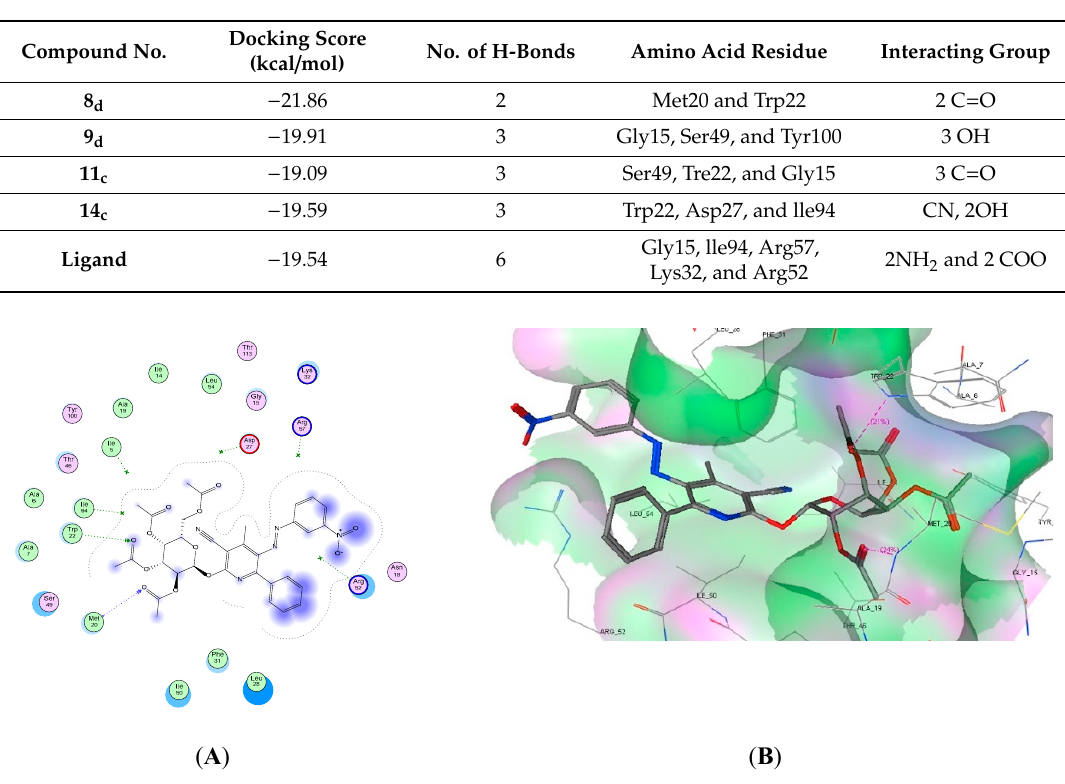
Table 5. The docking scores and binding interactions of the docked compounds inside the DHFR active site.